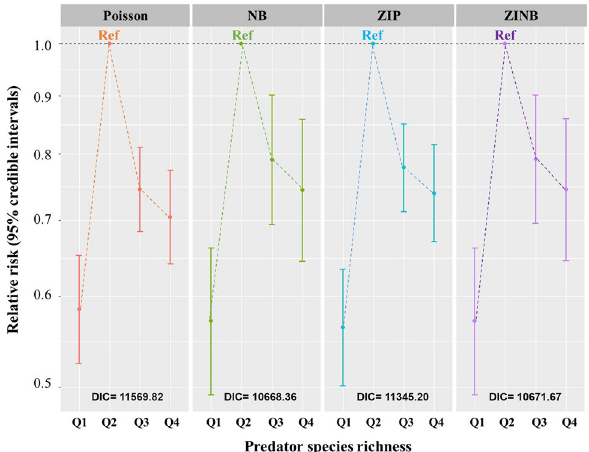
Figure 1. Association between the incidence of haemorrhagic fever with renal syndrome and predator species richness variables. Four models were employed, including the Poisson, negative binomial (NB), zero-inflated Poisson (ZIP), and zero-inflated negative binomial (ZINB) models, and the second quartile served as the reference. The NB model was selected as the best fit model due to its lowest DIC. The covariates included reservoir species richness, extent of deforestation, budget dependency, annual mean temperature, annual precipitation, relative humidity, agricultural area, urban area, and elevation (Q1–4 indicate 0–3, 4–8, 9–11, and 12–17, respectively).